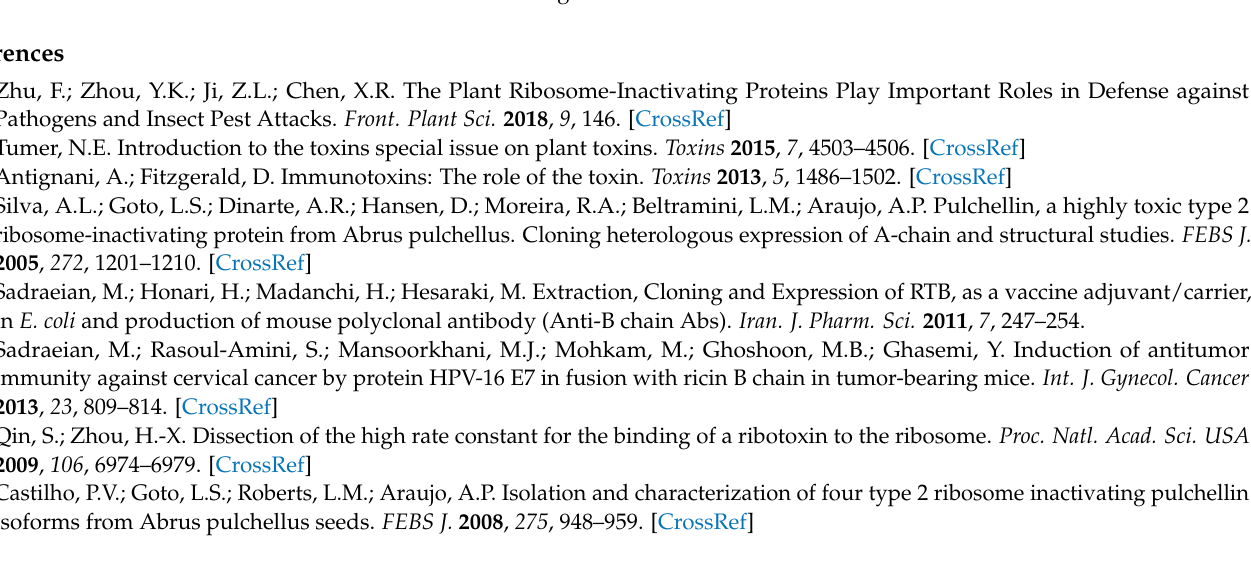
results of all potential mutants. Table S4. Validation scores of wild type and mutants form of PAC. Mutant models were obtained from SDM2 server. Table S5. Evaluation of 3D structure of a pulchellin containing all mutations model with Verify 3D, ERRAT, ProSAWEB, and Ramachandran Plot. Table highest validation score. Table S7. Pulchellin interaction amino acids (wild type and mutants) in the docking process. Residues of active site in N146V contributed the most, while Q121A contributed the least in docking process. Highlight amino acids indicate shared active site residues between homology prediction and molecular